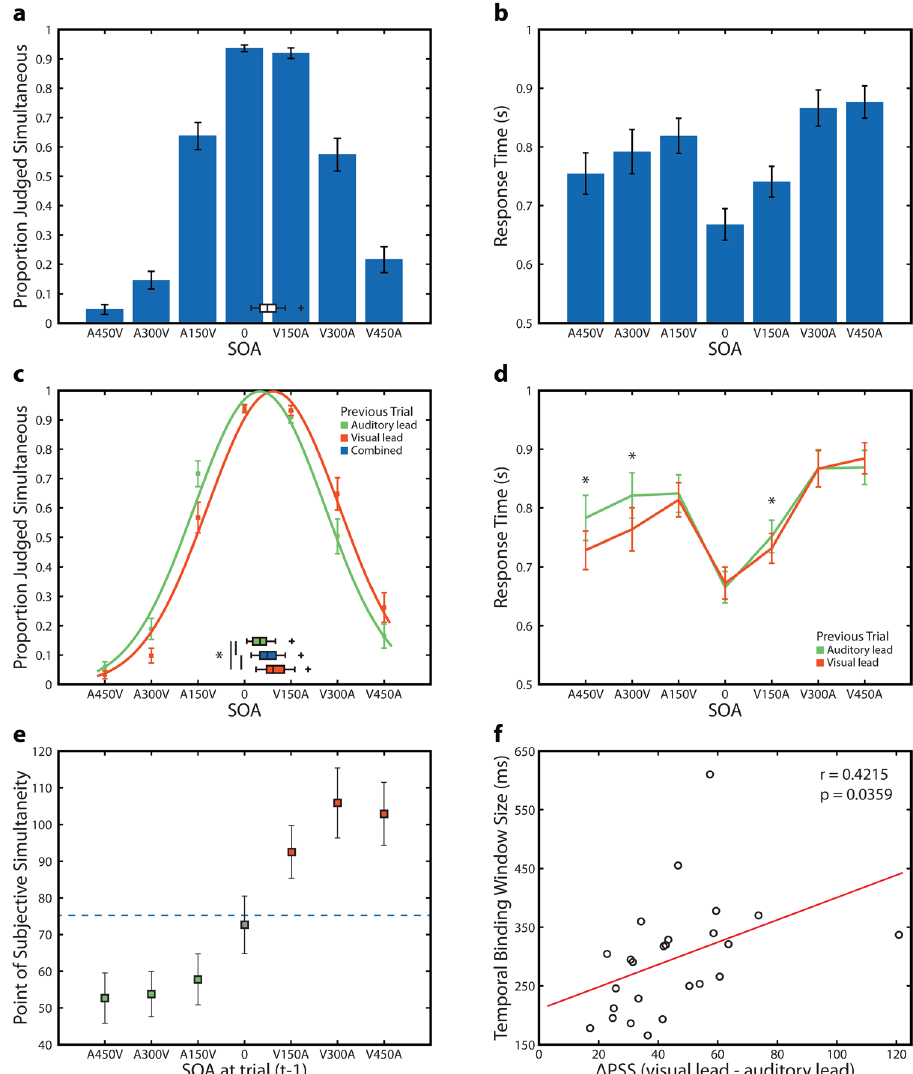
Figure 1. Behavioral Results. ( a ) Proportion of trials reported as synchronous for all 7 SOAs. Error bars indicate standard error of the mean. Inset box plot indicates PSS values. ( b ) Response times for all 7 SOAs. Error bars indicate standard error of the mean. ( c ) Proportion of trials reported as synchronous for all 7 SOAs separated by whether the previous trial was auditory leading (green) or visual leading (orange) and fit to a Gaussian distribution. Error bars indicate standard error of the mean. Gaussian fits are scaled to an amplitude of 1. The Inset box plots indicate PSS values for auditory leading trials (green), visual leading trials (orange) or the combination of both (blue). Asterisk marked bars indicate a significant paired sample t-test between PSS values. ( d ) Response time for all 7 SOAs separated by whether the previous trial was auditory leading or visual leading. Error bars indicate standard error of the mean. Asterisks indicate a significant difference between lead types. ( e ) PSS for psychometric functions fit separately to data sorted into 7 bins based on the SOA of the previous trial. Error bars indicate standard error of the mean. Solid line indicates the PSS when all data is pooled. ( f ) Relationship between TBW size and change in PSS. Change in PSS is calculated as [(PSS V lead) – (PSS A lead)] for consistency with previous reports. Red line indicates the linear regression